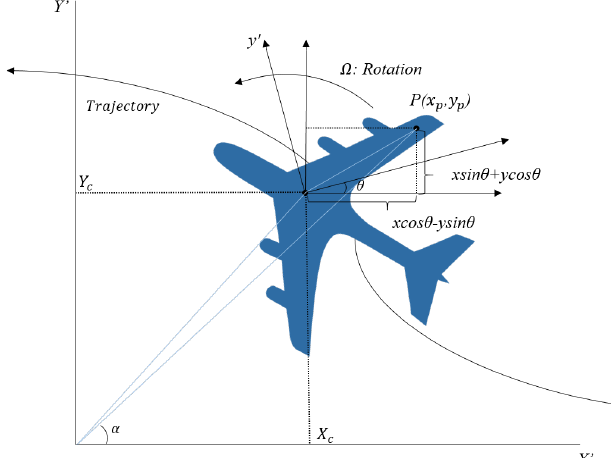
Figure 1. Simplified two-dimensional ISAR geometry.